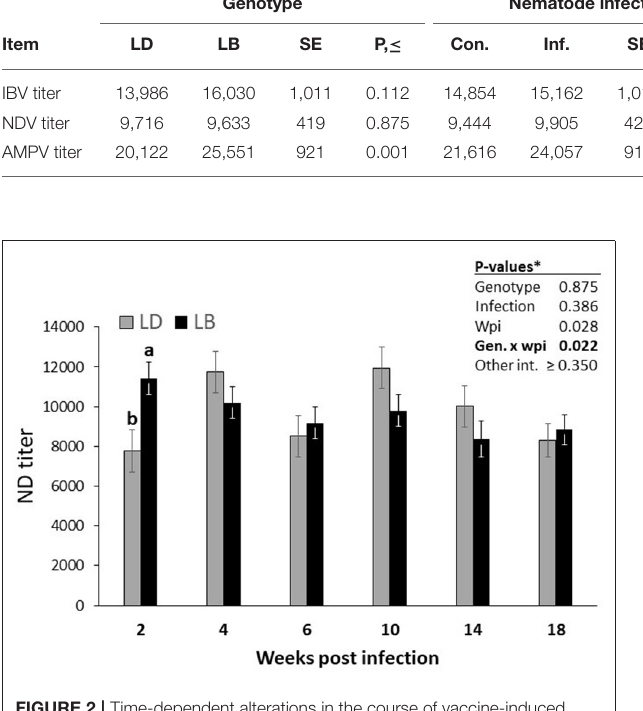
FIGURE 2 | Time-dependent alterations in the course of vaccine-induced NDV titers in Lohmann Brown Plus (LB) and Lohmann Dual (LD) genotypes over the experimental period. * Exact P- values for all possible interaction effects are presented in Table 2 . ab Different letters between two genotypes indicate significant differences at the same wpi ( p <